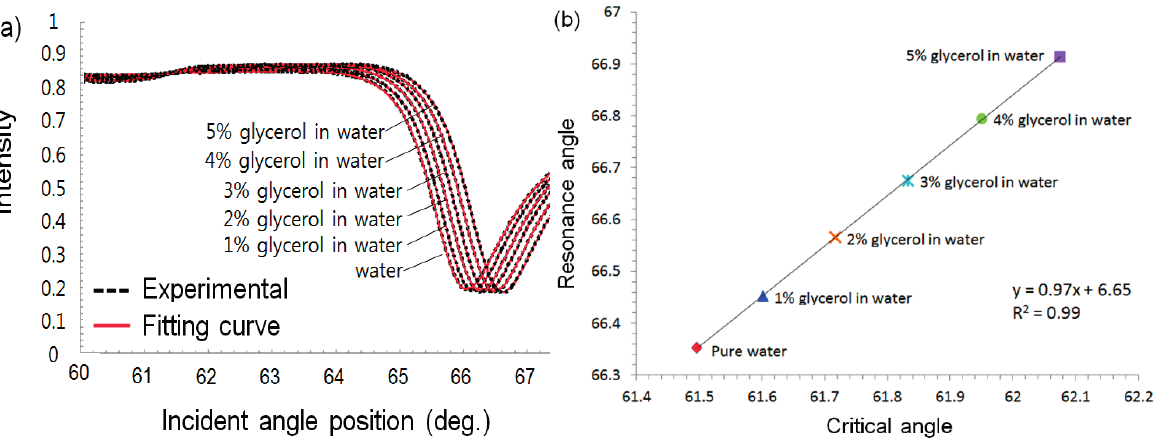
Figure 7. ( a ) Full SPR curves (black dotted lines) measured for a DIW and a glycerol- and the curves (red solid line) fitted by sigmoid-asymmetric method. ( b ) Correlation graph bulky refractive index due to glycerol-water solutions.